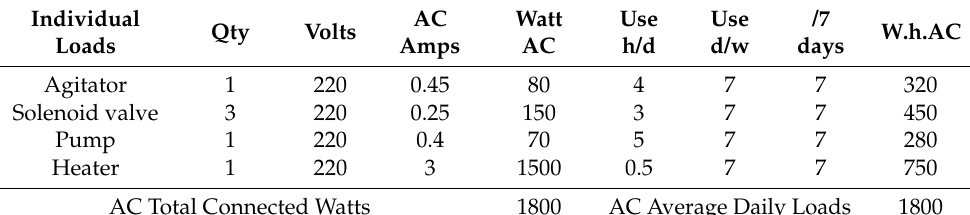
Table 1. Solar power system’s devices and